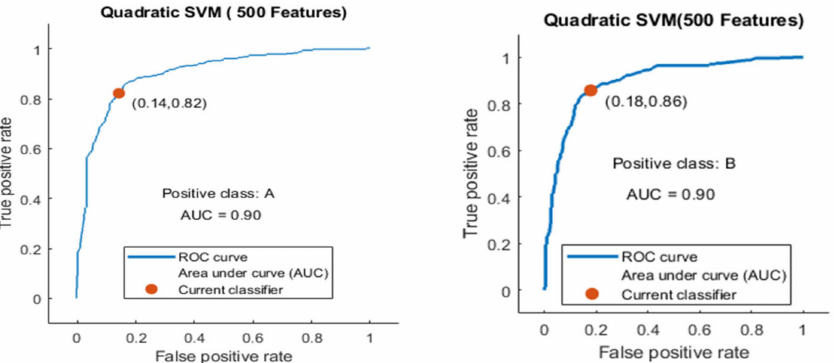
Figure 17. ROC curve for two classes A and B with 500 features and using 5-fold